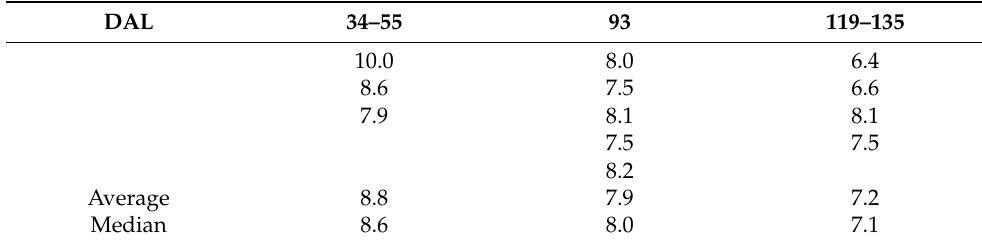
Table 5. Fork length (cm) for fish recaptured at Site 3 for three different days at liberty (DAL). DAL